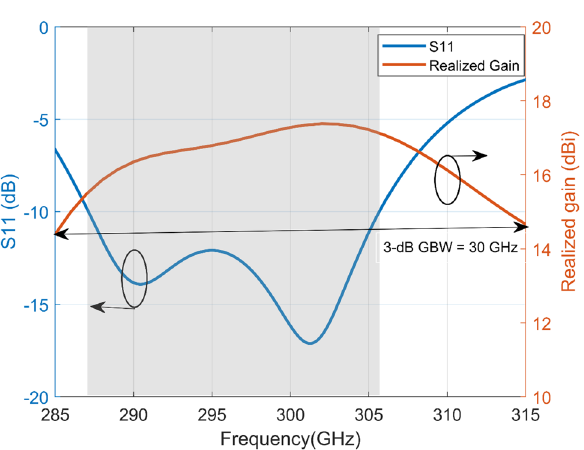
Figure 4. Simulated reflection coefficient (S11) and realized gain of the proposed antenna.